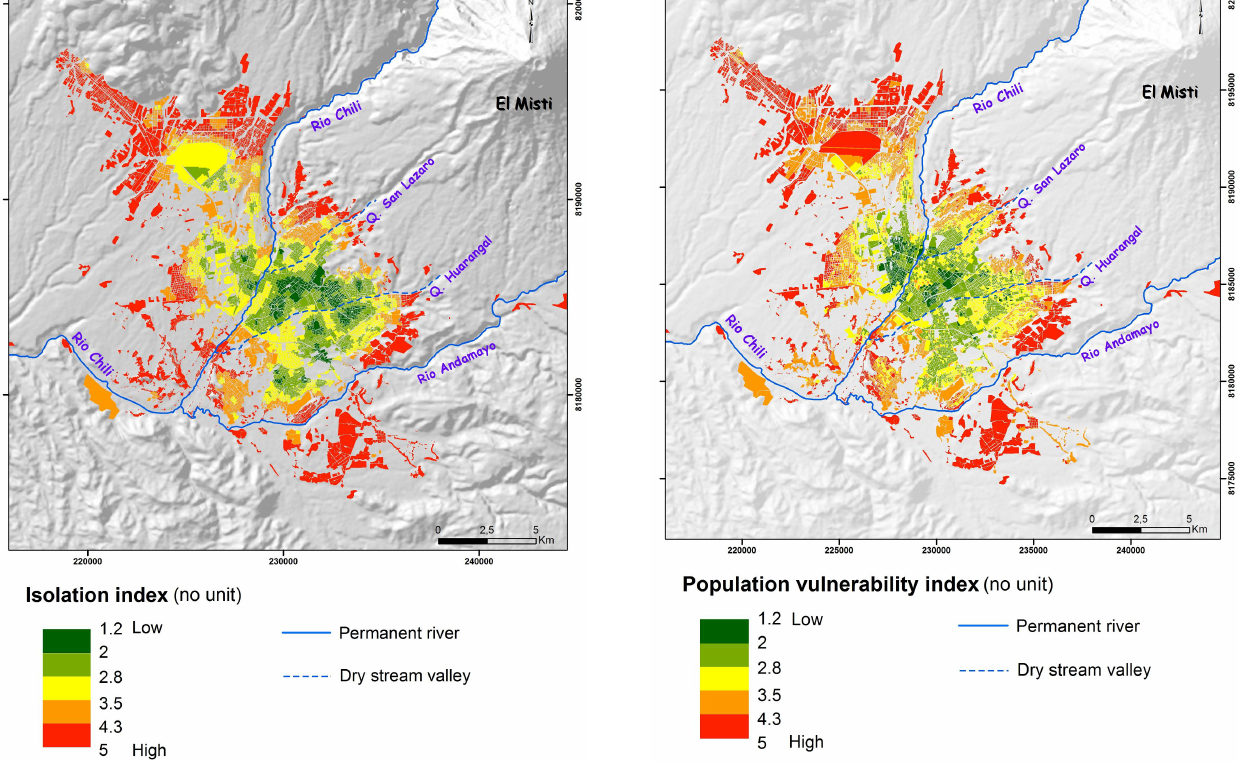
Fig. 12. Map of the overall population vulnerability in Arequipa. The overall vulnerability index comprises ofive classes according to Table 7 (PvI). The scale of original data (city block) results in a high level of